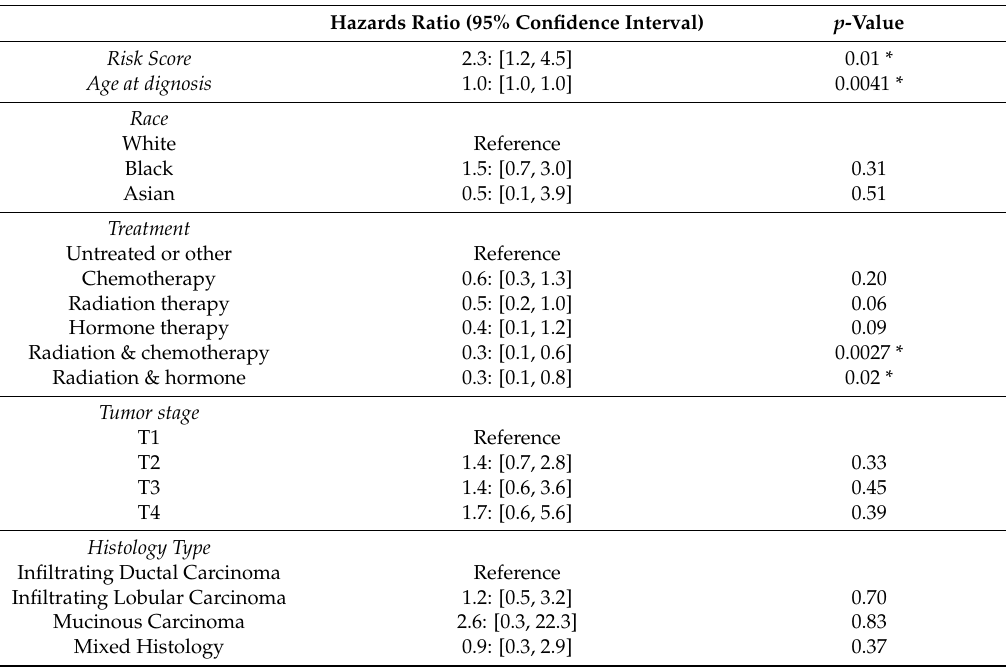
Table 4. Multivariate Cox regression survival analysis.